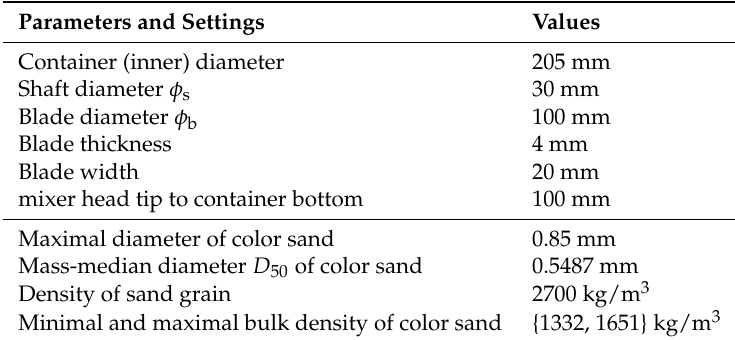
Figure 2. ( a ) experimental setup; ( b ) sketch of the mixer head composed of a shaft and one set of two blades; ( c ) a snapshot after mixing with a clear view of the increase of surface height (sideview); ( d ) an example of surface mixing pattern at an early stage of mixing (after two revolutions). Table 1. Parameters and settings of the